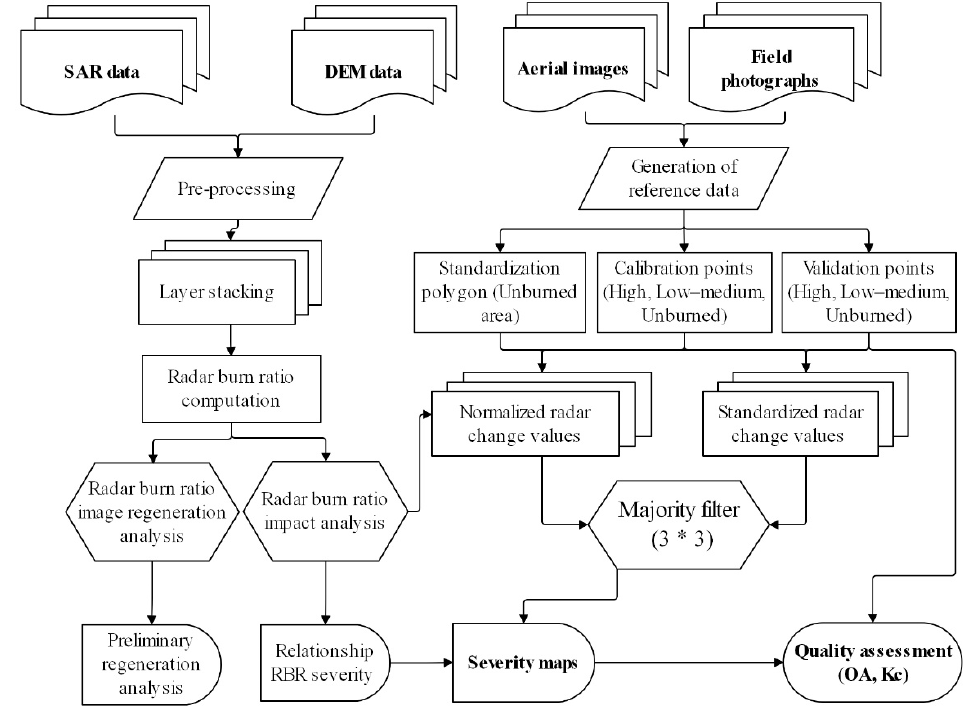
Figure 2. General framework of this study.